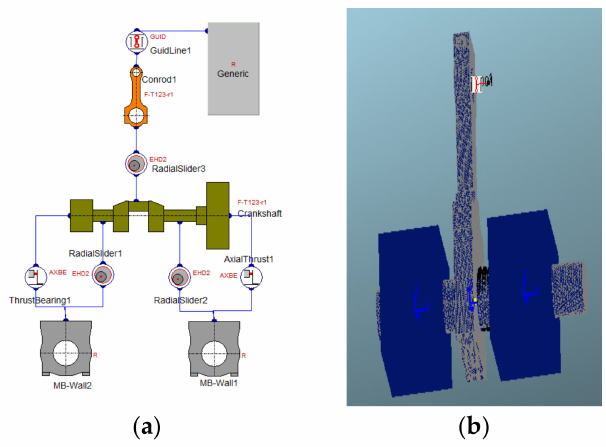
Figure 1. Multibody dynamics model: ( a ) 2D Excite model; ( b ) 3D model.